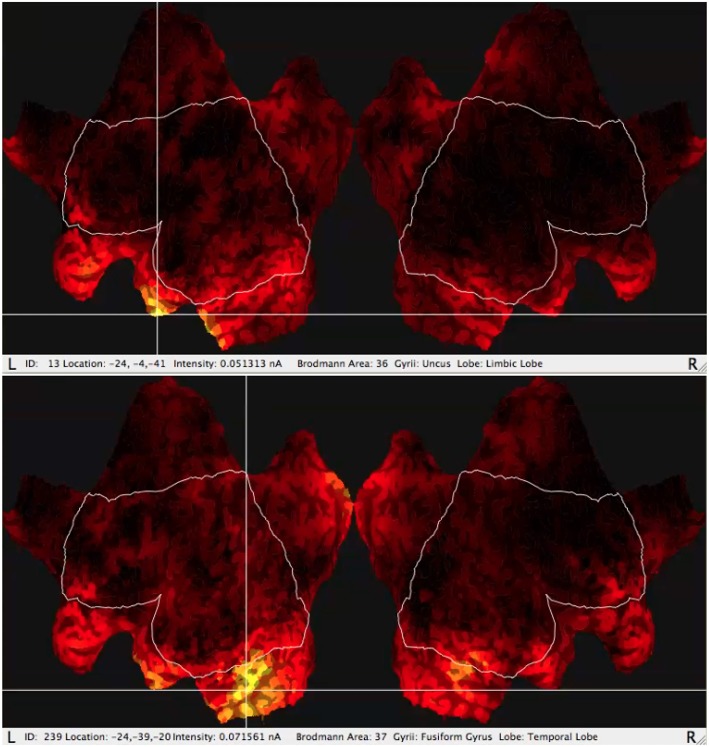
Typical results of GeoSource BA activity visualization on the brain cortex so-called Flat Map. The increase of activity in BA36 (Uncus Lobe, Limbic Lobe) for good choice and BA37 (Fusiform Gyrus, Temporal Lobe) for bad choice are indicated.